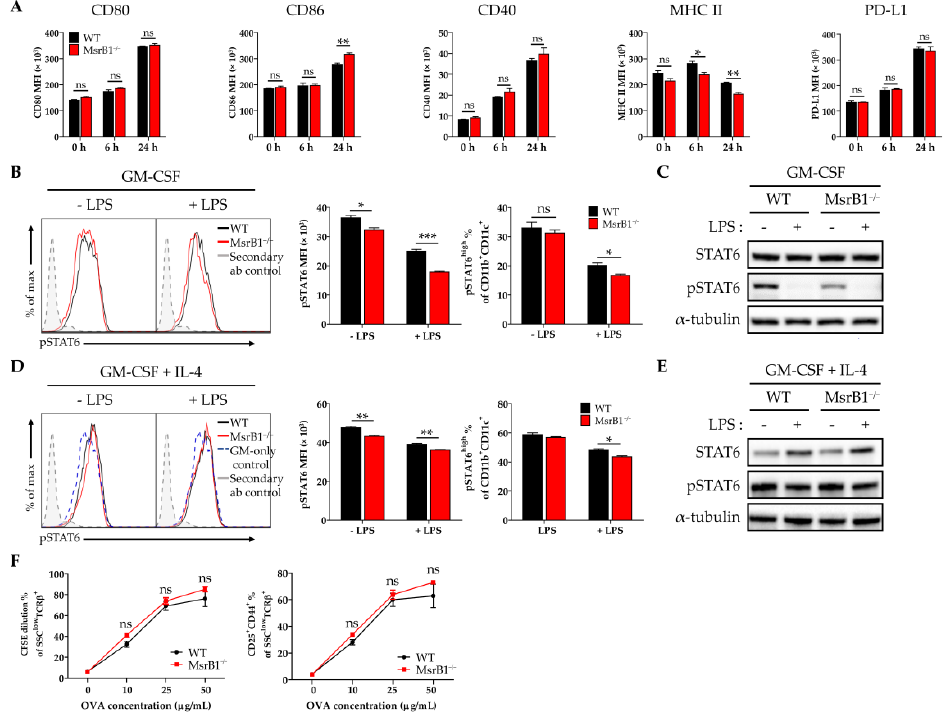
Figure 3. The ability of MsrB1 to control BMDC maturation and T-cell activation associates with MsrB1 regulation of STAT6 activation. ( A ) WT and MsrB1 −/− BMDCs were generated with IL-4